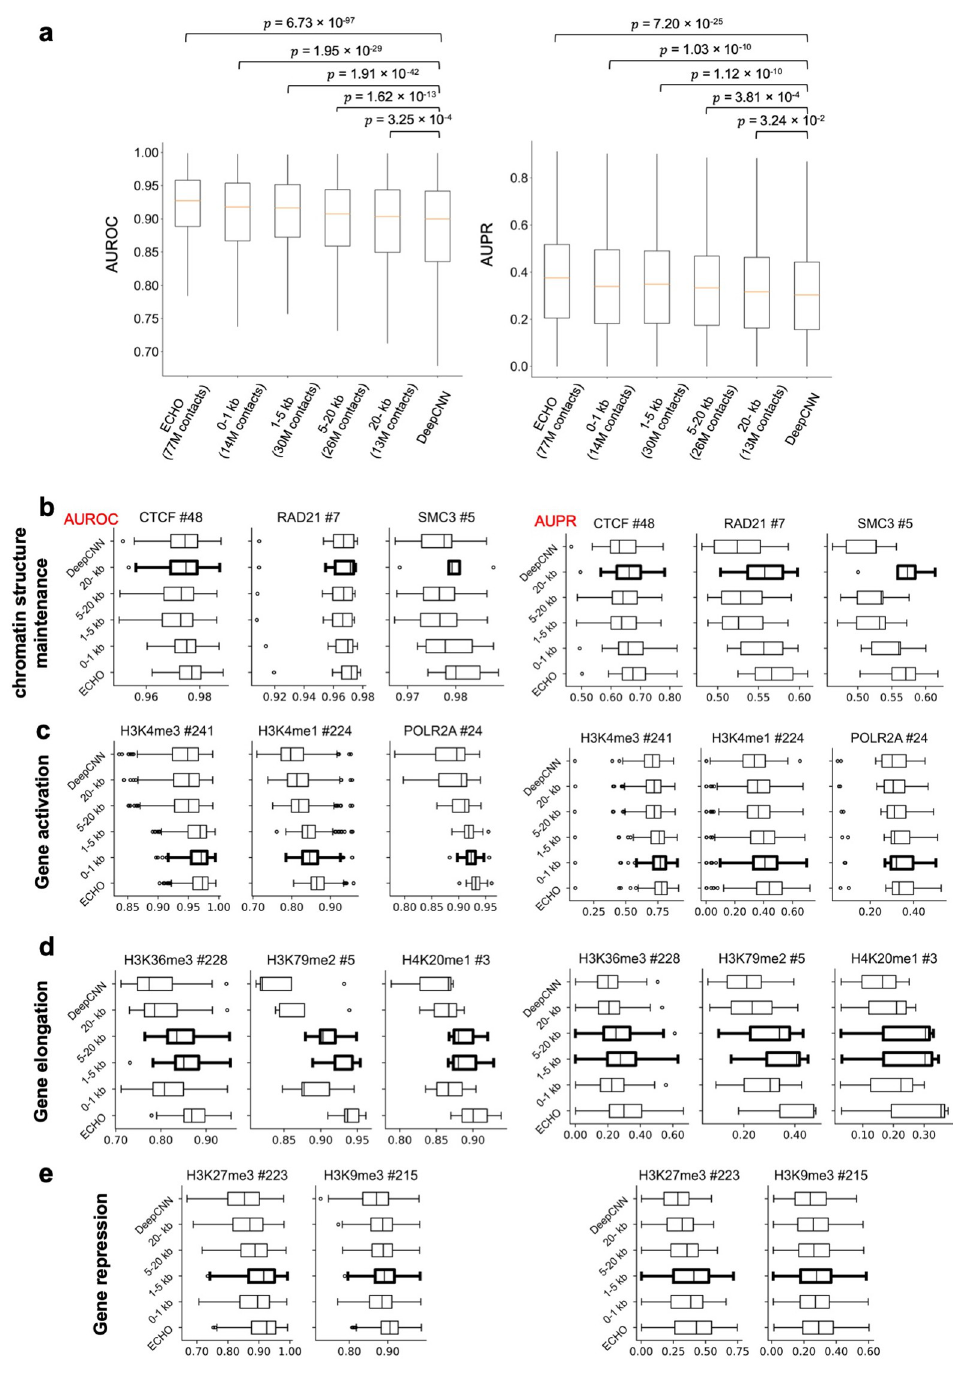
Fig 2. How much chromatin contacts helps to predict a chromatin feature is contact-distance specific. (a) Comparing the performance of ECHO using Micro-C contacts from specified contact distance ranges. The x-axis shows four groups with different contact distance ranges and the total number of Micro-C contacts used. The p -values calculated by paired t -tests are given. (b-e) show the effects of Micro-C contact distances on the prediction of chromatin structure maintenance related TFs, gene activation related chromatin features, gene elongation marks, and gene repressive marks, respectively.